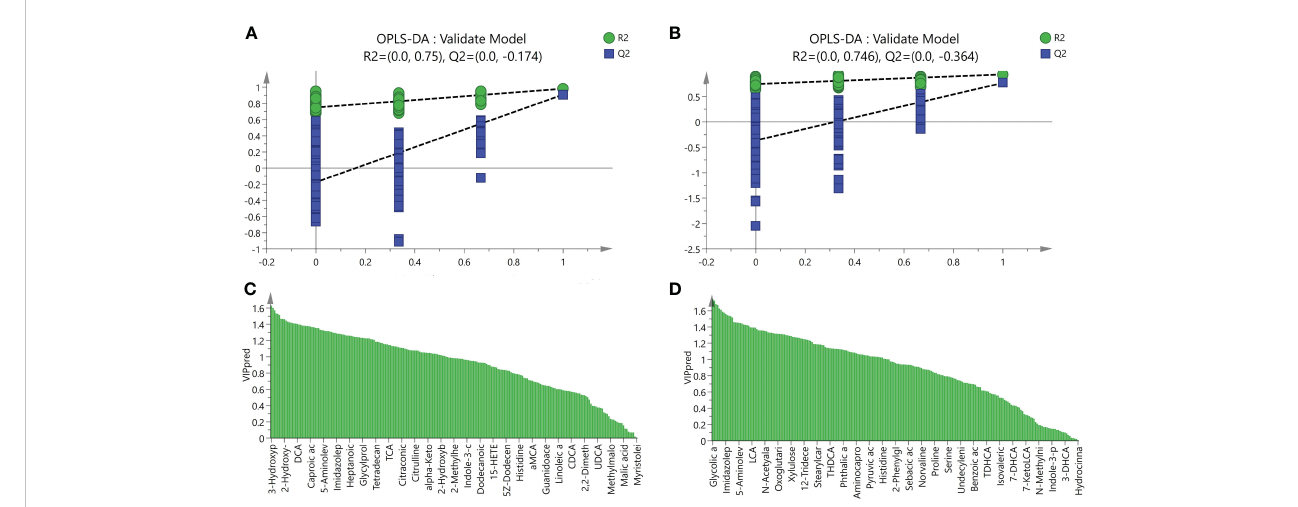
FIGURE 6 Validation model of OPLS-DA and VIP values. (A) The validation model of OPLS-DA for the NASH and Control groups, green dots represented R2 and blue squares represented Q2, (B) The validation model of OPLS-DA for LGZG and NASH groups, green dots represented R2 and blue squares represented Q2, (C) VIP values of OPLS-DA for the NASH and Control groups, X-axis represented names of metabolites and Y-axis represented VIP values, (D) VIP values of OPLS-DA for the NASH and Control groups, X-axis represented names of metabolites and Y-axis represented VIP values.